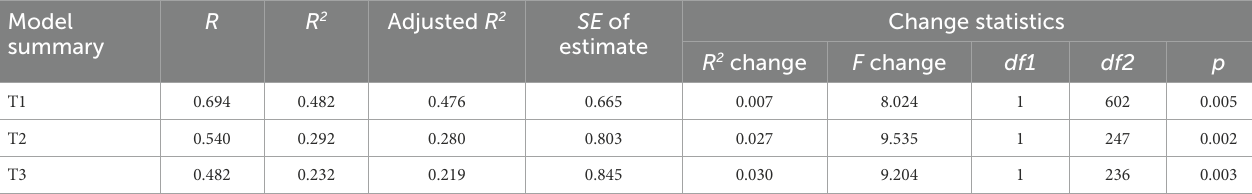
TABLE 11 Model summary for multiple regression of burnout predictors with Forward model. Model summary